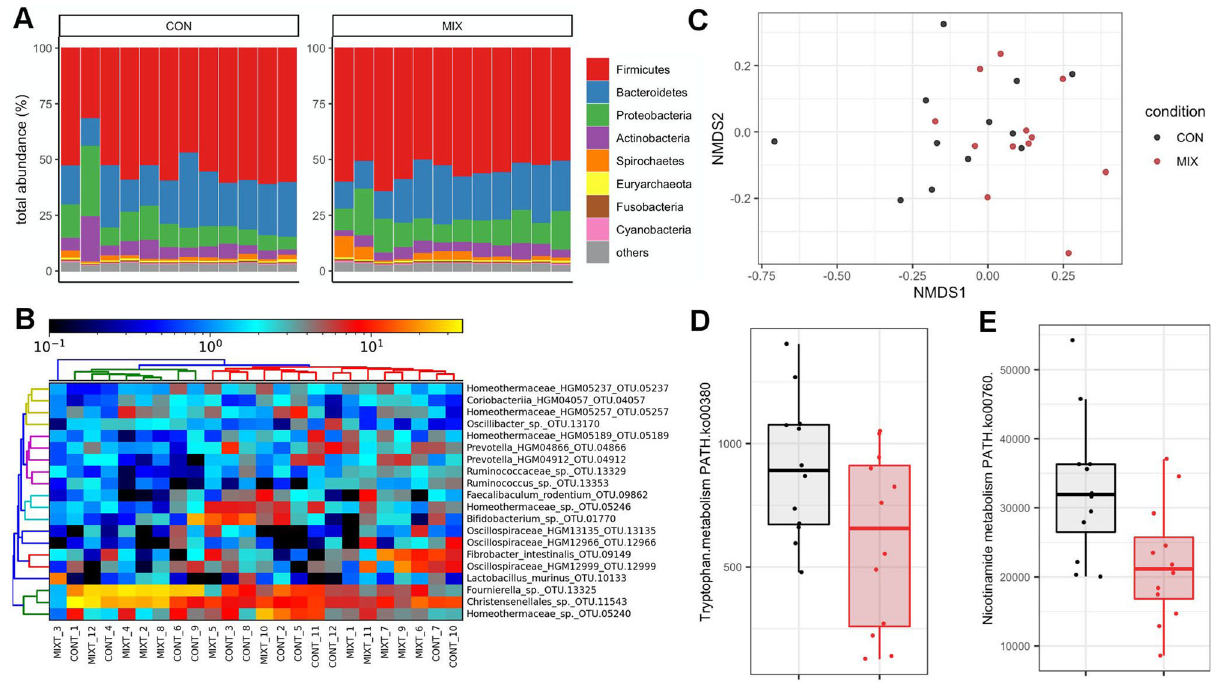
Fig. 3 Shotgun metagenomics shows no alterations in the caecum microbiota composition upon exposure to the mixture of six pesticides. A Gut caecum microbiota composition pro fi les at the phylum level. B Classi fi cation of samples from the most frequently found species-level operational taxonomic units with IGGsearch failed to show any alterations in different bacterial populations in response to the pesticide mixture. C Principal coordinates analysis plot using the NMDS ordination of Bray – Curtis distances. Pathway analysis shows reduction in tryptophan ( D ) and nicotinamide ( E ) metabolism potential.